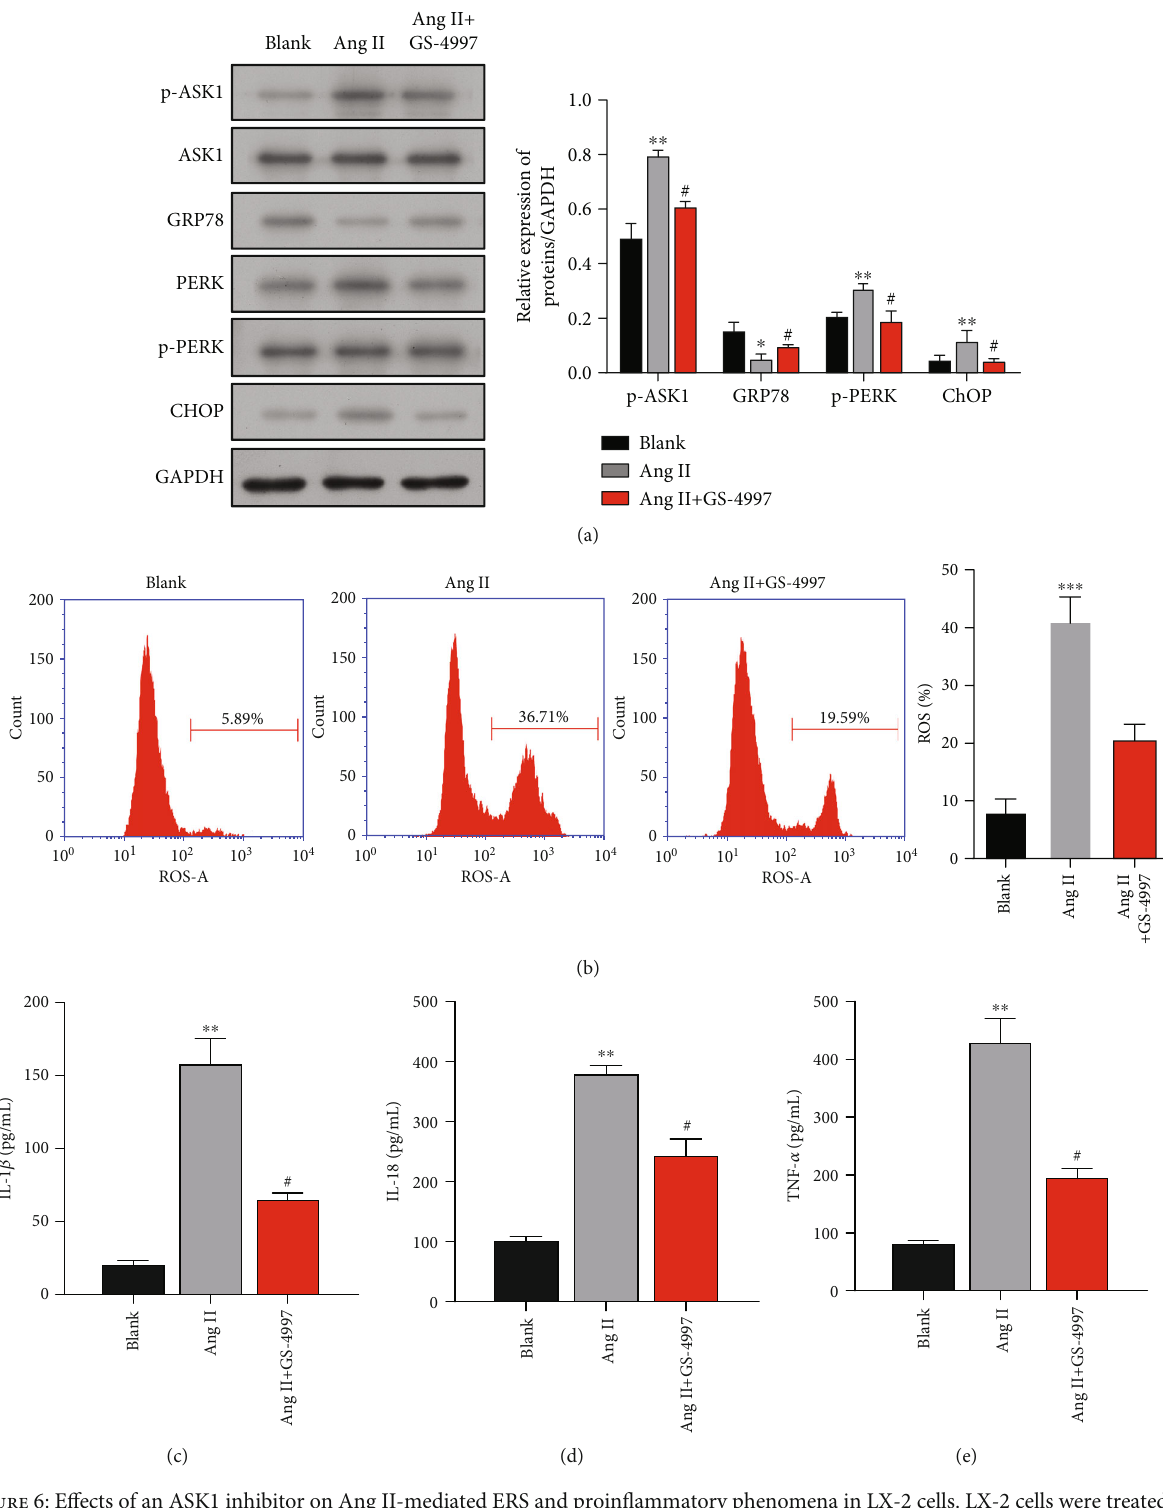
Figure 6: E ff ects of an ASK1 inhibitor on Ang II-mediated ERS and proin fl ammatory phenomena in LX-2 cells. LX-2 cells were treated with Ang II alone or cotreated with Ang II and an ASK1 inhibitor (GS-4997). (a) The protein bands of p-ASK1, ASK1, GRP78, PERK, p-PERK, and CHOP are shown in the left panel, and the corresponding protein levels are shown in the right panel. (b) The ROS levels measured using fl ow cytometry are shown in the left panel, and quanti fi ed results for ROS generation are depicted in the right panel. ELISA was used to determine the expression levels of proin fl ammatory cytokines, including IL-1 β (c), IL-18 (d), and TNF- α (e). Results are expressed as the meanvalue ± standard deviation (SD). ∗ p < 0 : 05 , ∗∗ p < 0 : 01 , and ∗∗∗ p < 0 : 001 vs. blank. # p < 0 : 05 vs. Ang